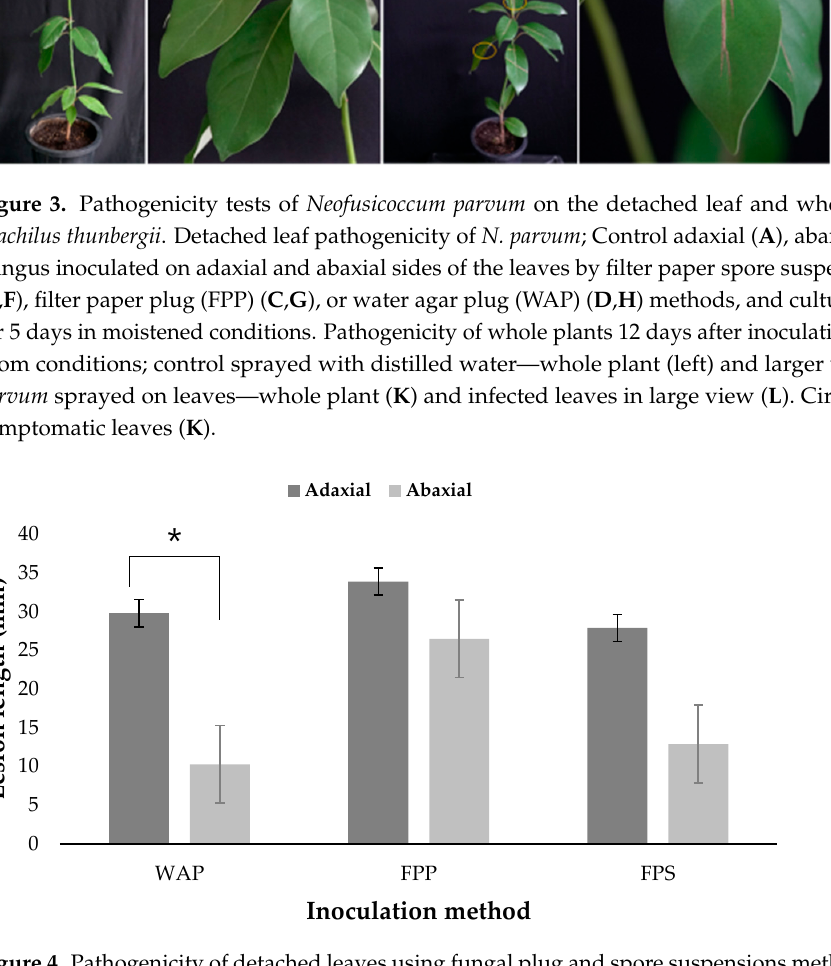
Figure 4. Pathogenicity of detached leaves using fungal plug and spore suspensions methods. Fungal inoculations were performed on adaxial and abaxial sides of the leaves. WAP, FPP, and FPS represent the water agar plug, filter paper plug, and filter paper spore suspensions, respectively. * indicates a statistically significant difference between the average lesion lengths on adaxial and abaxial sides of the leaves by Student’s t -test ( p < 0.05).